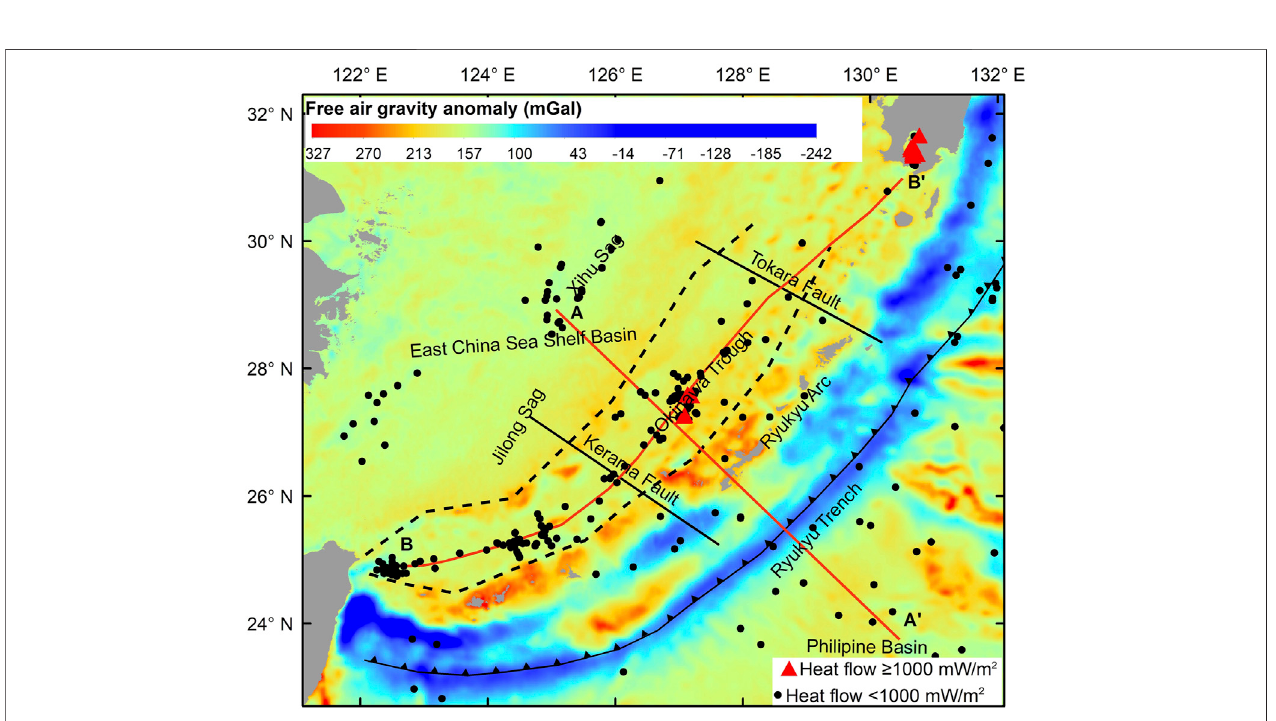
FIGURE 3 | The free-air gravity anomalies (Sandwell et al., 2014) and the heat fl ow stations from the database of the International Heat Flow Commission.